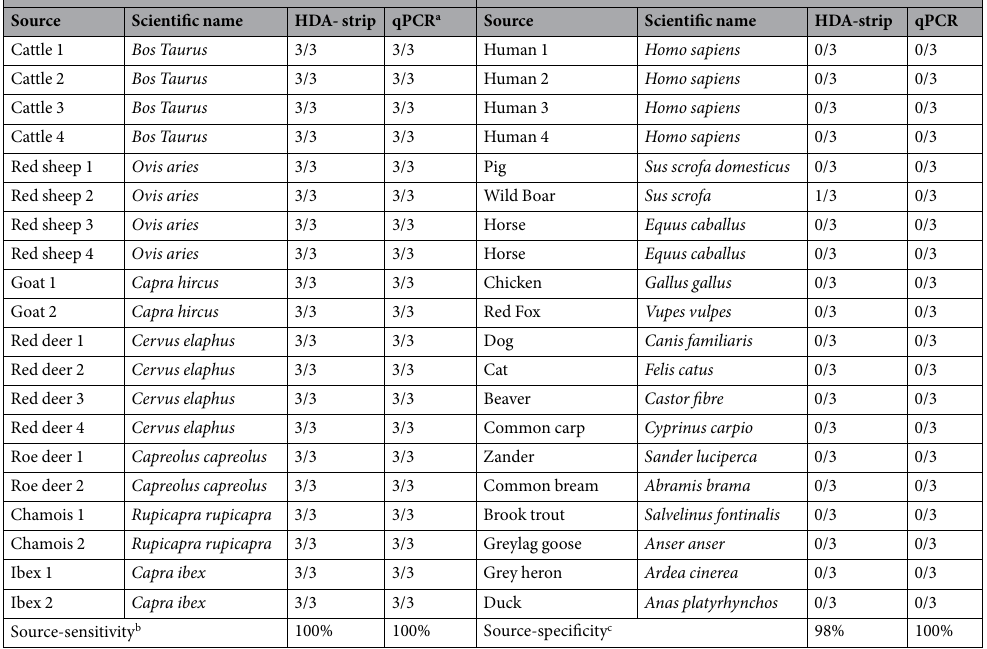
Table 1. Source-sensitivity and source-specificity results of the BacR HDA-strip assay and the BacR qPCR assay. Assays were evaluated on 20 single ruminant (target) and 20 single non-ruminant (non-target) faecal samples, each tested at a concentration of 1 ng extracted DNA per reaction. The results are given as the number of positive reactions from triplicate analyses and as calculated sensitivity and specificity percentages. a Marker copy numbers ranged from 10 4 to 10 5 copies per reaction based on qPCR analysis with plasmid standards. b Source sensitivity (%): (true positives)/(true positives + false negatives) × 100. c Source specificity (%): (true negatives)/(true negatives + false positives) × 100.